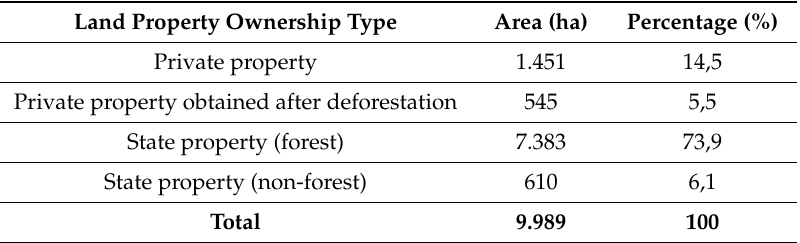
Table 6. The percentages of di ff erent ownership types in the